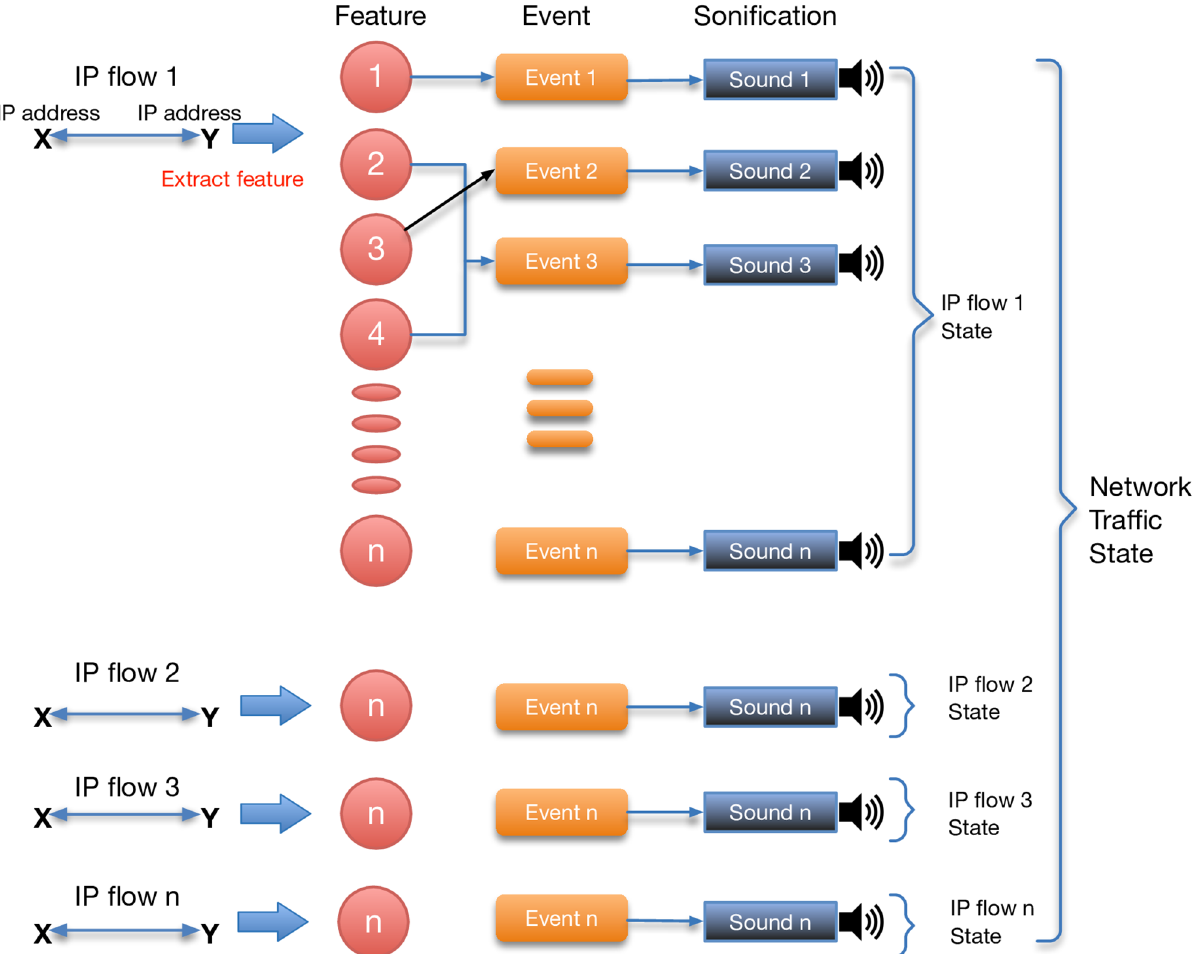
Fig 4. IP flow representation. Illustration of multiple IP flows containing a range of different events and even combinations are mapped to different sounds resulting in a sonic representation of the overall traffic state.